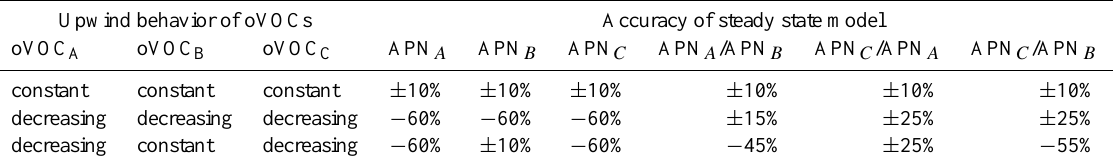
Table 2. Summary of conclusions from comparison of steady state and time dependent